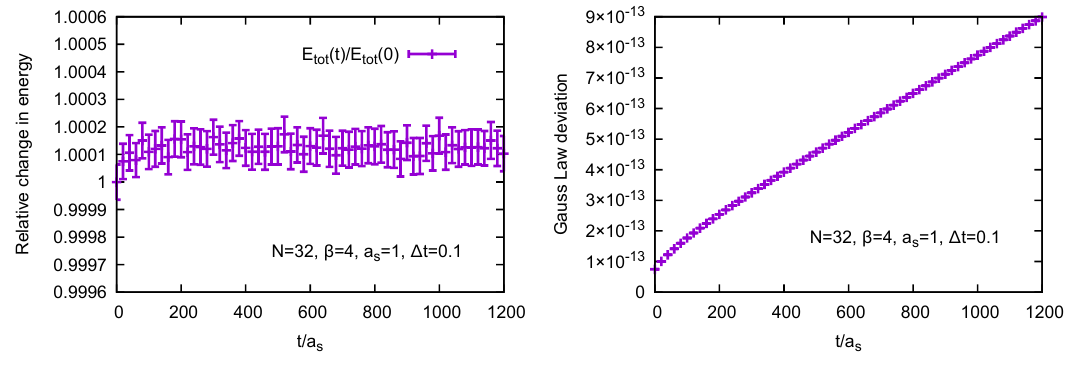
Figure 12 . Energy conservation (top) and Gauss’s Law preservation (bottom) in the absence of sources at β = 4 .